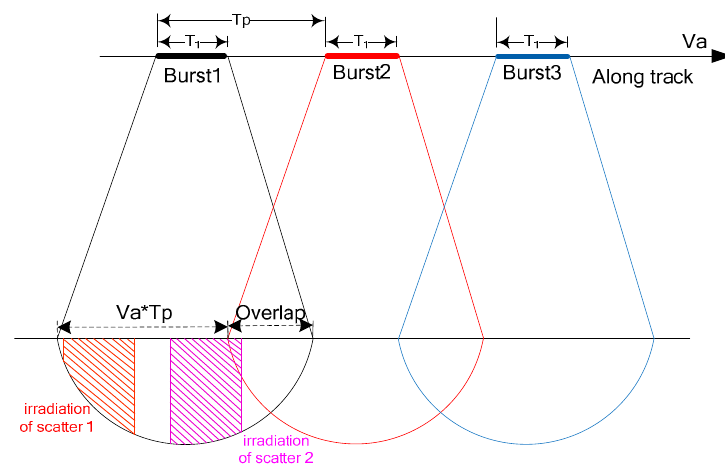
Figure 2. ScanSAR working sequence of a single subswath.